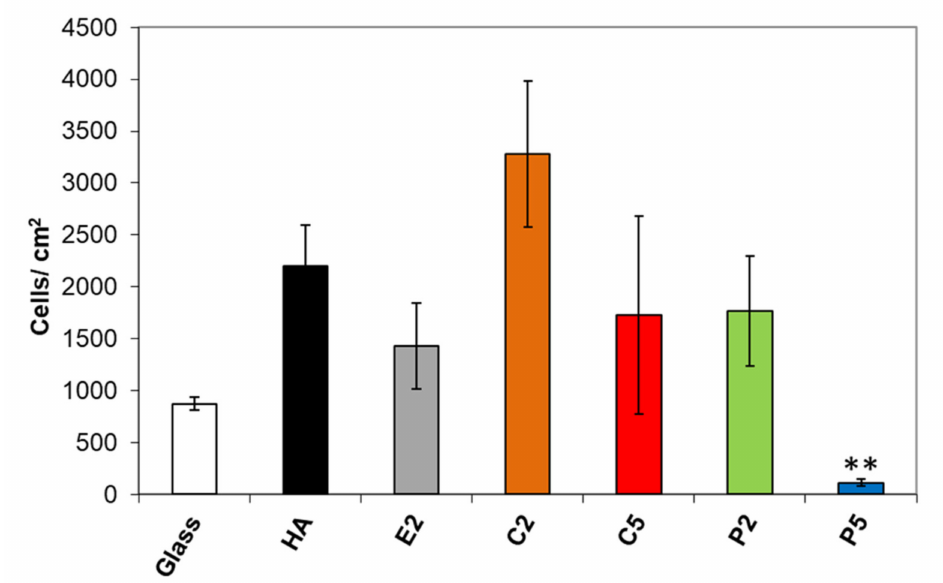
Figure 7. Change in osteoblast adhesion on the AgHA series. (** p < 0.01; compared to